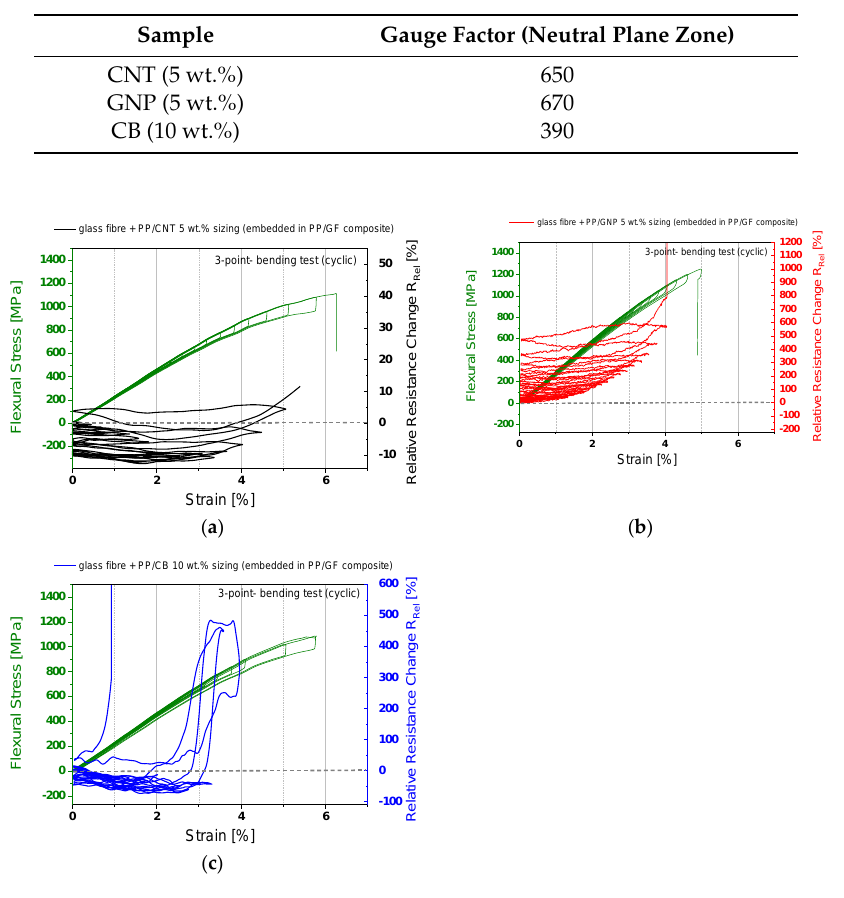
Figure 8. Cyclic electro-mechanical response behaviour of in-line nanostructured sensor fibre using 5 wt.% CNT ( a ), 5 wt.% GNP ( b ) and 10 wt.% CB ( c ) embedded in the neutral plane zone during a quasi-static 3-point bending test (span to length L / h ratio of 33, a stepwise increase of mechanical loading of 50